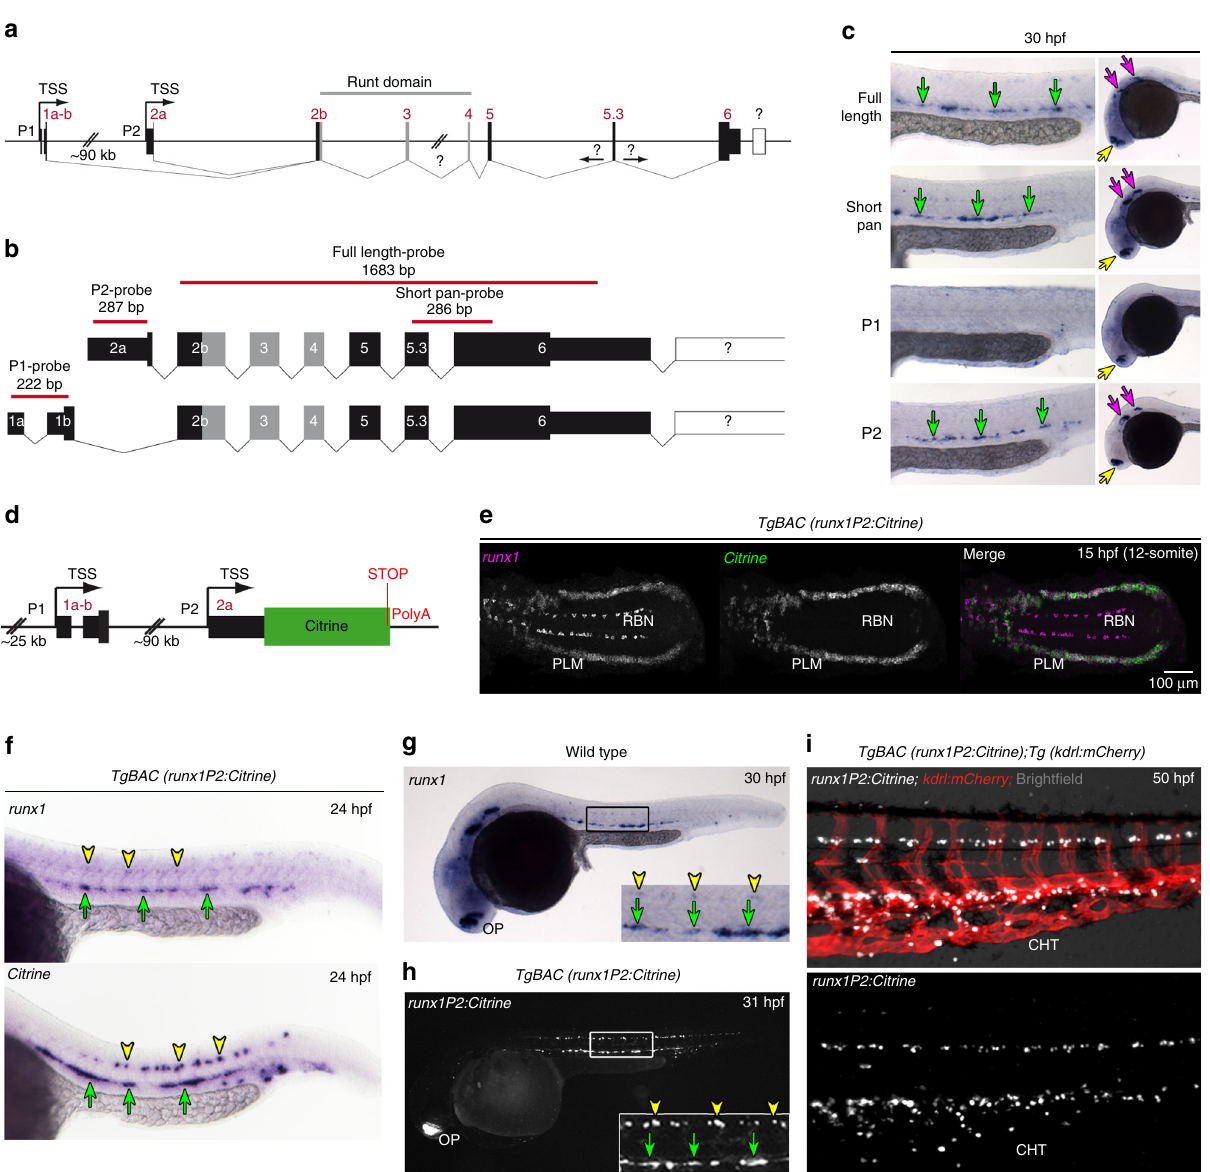
Fig. 1 Generation of a zebra fi sh BAC transgenic reporter line for runx1 . a Schematic representation of the zebra fi sh runx1 locus. Exon nomenclature adjusted to the human RUNX1 locus. P1 and P2 indicate the distal and the proximal promoter respectively (TSS: transcriptional start site). b Schematics of the two alternative transcripts derived from the alternative promoters P1 and P2. Transcript-speci fi c and pan binding ISH probes are indicated with their respective lengths. c ISH for runx1 isoforms in 30 hpf embryos. Left panel: trunk region. Right panel: head region. Green arrows point to the HE, yellow arrows show the olfactory placode and purple arrows depict neurons in the brain region. d Schematic of the recombineered 97a02 BAC. A Citrine reporter cassette was placed downstream of the P2 ATG. e Confocal microscopy image of a fl at mounted 15 hpf embryo after double FISH for runx1 and Citrine in TgBAC(runx1P2: Citrine) depicting the region of the posterior lateral plate mesoderm (PLM) and Rohon-Beard neurons (RBN). Maximum intensity projection of a 58 µ m stack. f – h Gene expression analysis for runx1 and runx1P2:Citrine during de fi nitive haematopoiesis. Green arrows point to the HE. Yellow arrowheads point to neurons in the spinal cord. f ISH for runx1 or Citrine in 24 hpf TgBAC(runx1P2:Citrine) embryos. g ISH for runx1 in 30 hpf embryos. h Representative fl uorescent microscopy image of a 31 hpf TgBAC(runx1P2:Citrine) embryo. Insets in ( g and h ) enlarge the boxed region. i Fluorescent microscopy image of a 50 hpf double transgenic TgBAC(runx1P2:Citrine);Tg(kdrl:mCherry) embryo focusing on the region of the caudal haematopoietic tissue